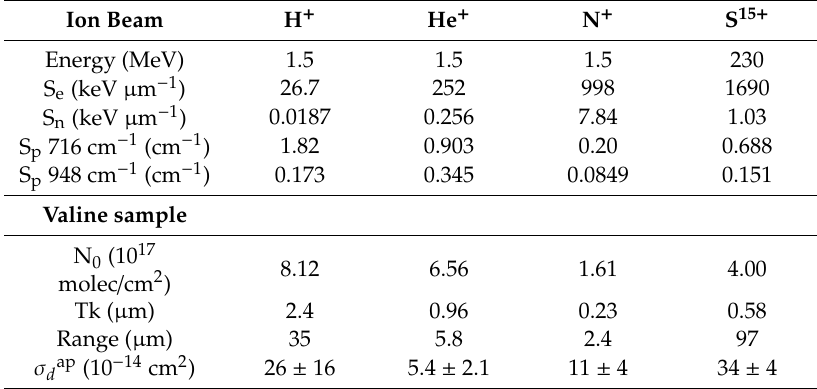
Table 4. Relevant characteristics of the four irradiations: beam energy, electronic and nuclear stopping powers for valine, initial absorbances for the 716 and 948 cm − 1 bands, initial column density, initial sample thickness, maximum beam penetration (range) and measured apparent destruction cross